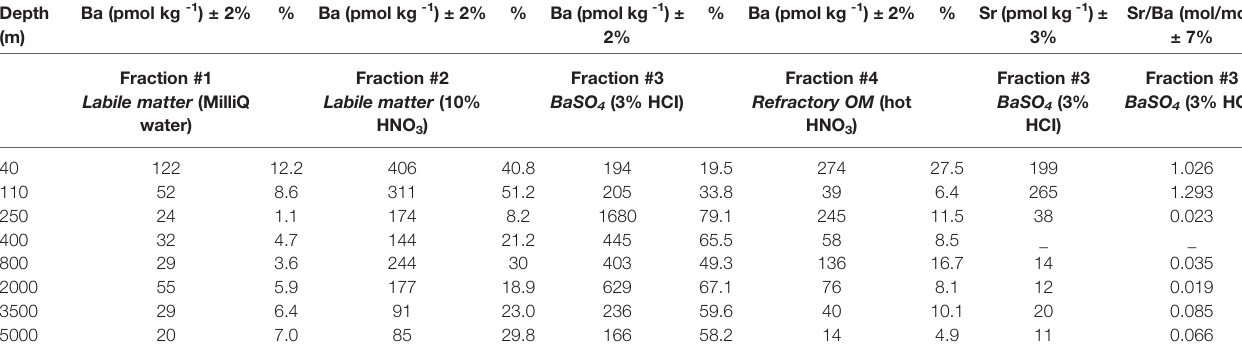
TABLE 1 | Ba concentrations (pmol kg -1 ) determined in the different particulate fractions at station K3 using the sequential leaching method of Ganeshram et al. (2003), slightly modi fi ed.